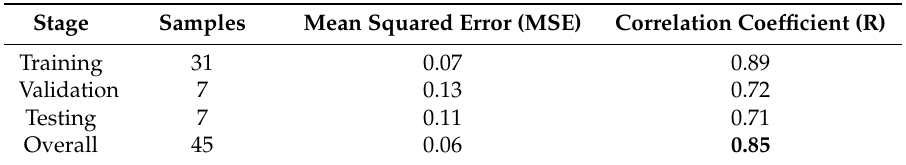
Table 1. Statistical results of Model 1 showing the number of samples, mean squared error (MSE) and correlation coefficient (R) for the training, validation and testing stages as well as the overall model.